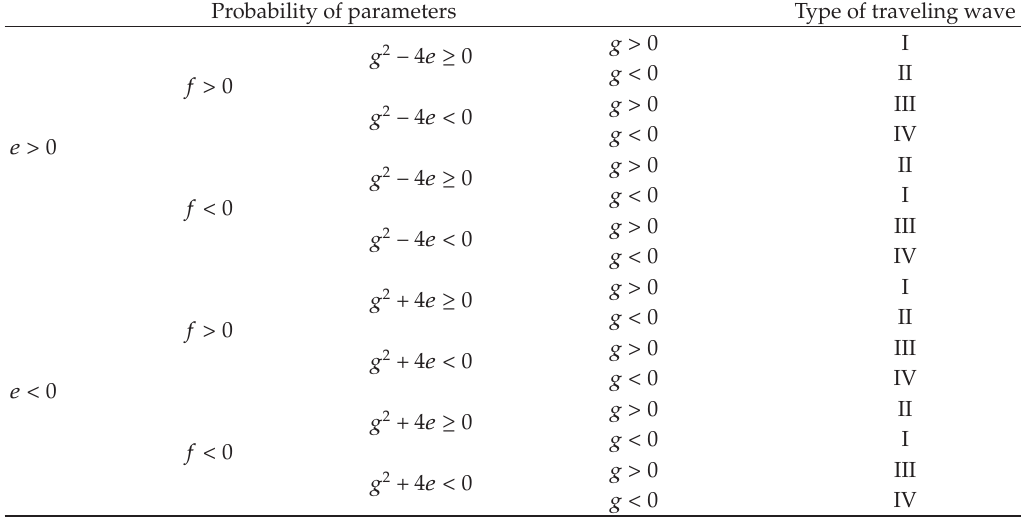
Table 1: Bounded travelling waves of (cid:5) 1.1 (cid:6) under di ff erent parameter conditions. Probability of parameters Type of traveling wave g 2 − 4 e ≥ f > 0 e > 0